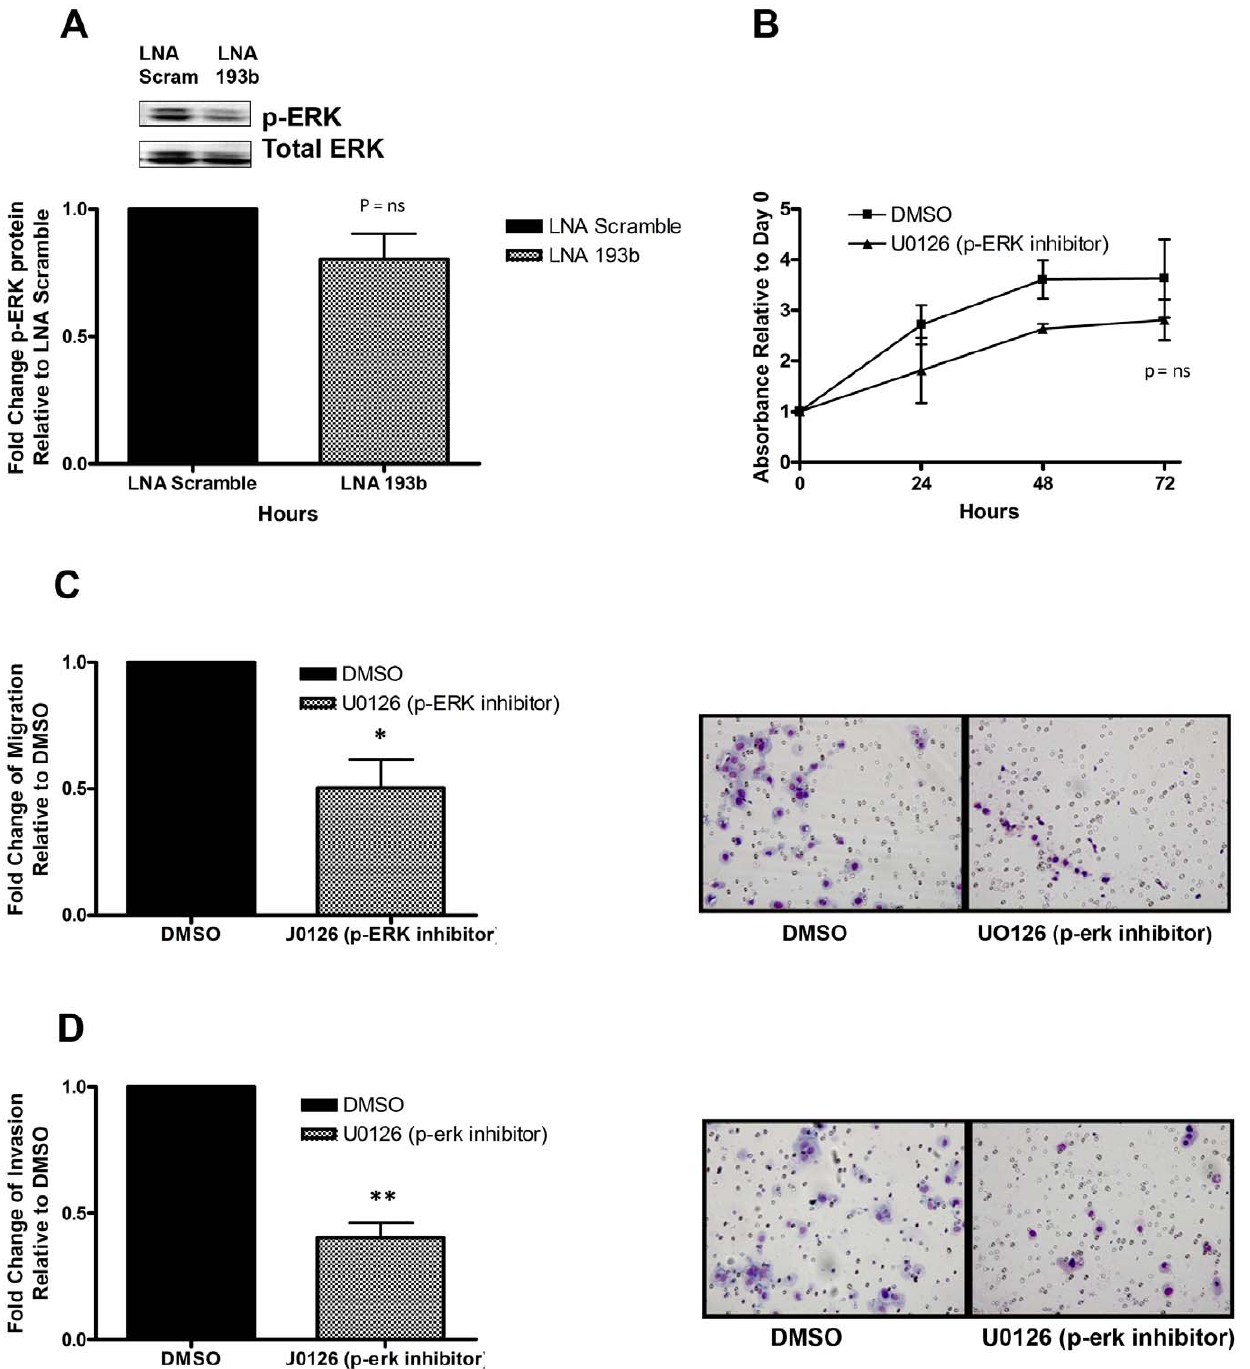
Figure 4. P-Erk expression contributes to cell viability, migration and invasion. Western blotting of p-ERK was measured in FaDu cells 72 hours post transfection with LNA-193b (40 nM) or LNA-scrambled (40 nM); images (above), quantification (below). (B) Cell viability of FaDu cells was assessed by the MTS assay 24, 48 and 72 hours after treatment with U0126 (10 uM) or vehicle control DMSO (10 uM). (C) Representative images (right) and quantification (left) depicting the reduced ability of FaDu cells to migrate after treatment with U0126 (10 uM) or vehicle control DMSO (10 uM). (D) Representative images (right) and quantification (left) depicting the reduced ability of FaDu cells to invade after treatment with U0126 (10 uM) or vehicle control DMSO (10 uM). *P , 0.05, **P , 0.005, P=ns (not significant).